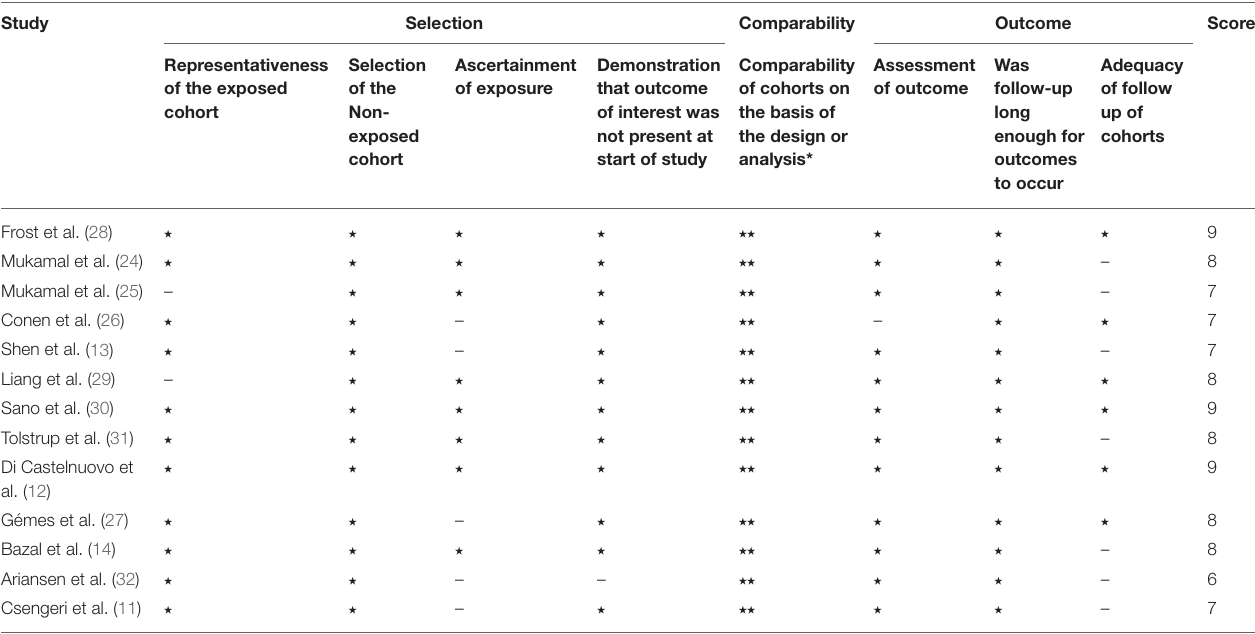
TABLE 2 | Quality assessment using the Newcastle-Ottawa Scale for cohort